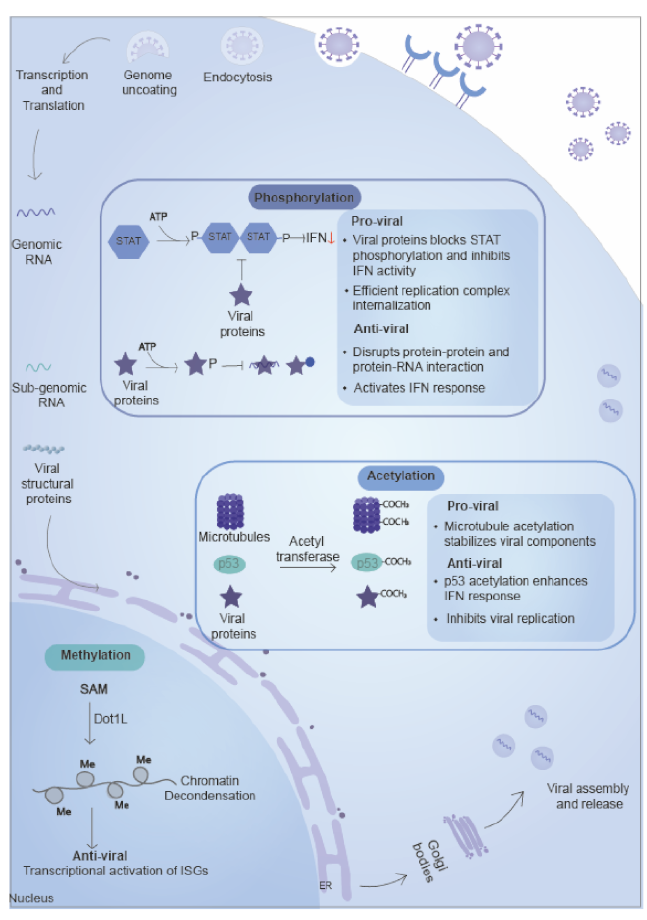
Figure 4. Small molecules/chemical group based PTMs. Small chemical groups such as phosphate, methyl, acetyl, and ionic groups are added to proteins by specific enzymes. Phosphorylation involves kinases which transfer phosphate group and play a role in protein-protein interaction, thereby affect- ing protein localization and signaling pathways. Methylation of host and viral proteins involved methyl group transfer from substrate protein by the help of methyltransferases. Methylation plays a role in modulating gene expression by regulating chromatin condensation, regulating both host gene expression and transcription of integrated viral genomes. Acetylation of histone proteins regulate gene expression and microtubule organization and affect viral